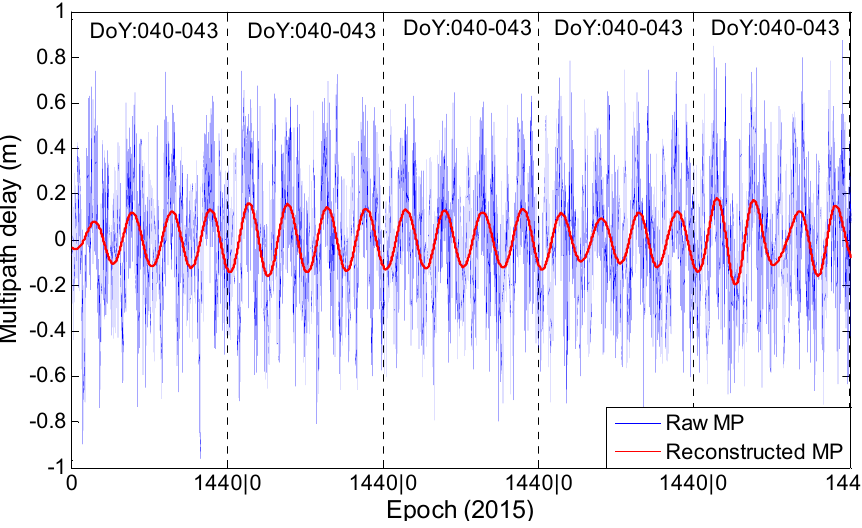
Figure 14. The raw and the reconstructed multipath series of C04 at station JFNG.